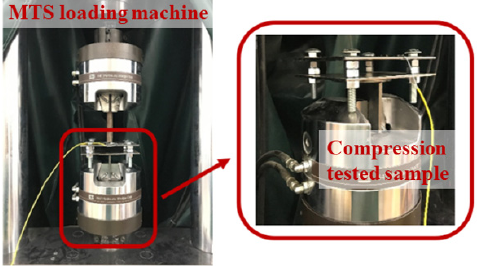
Figure 7. Compression test setup.